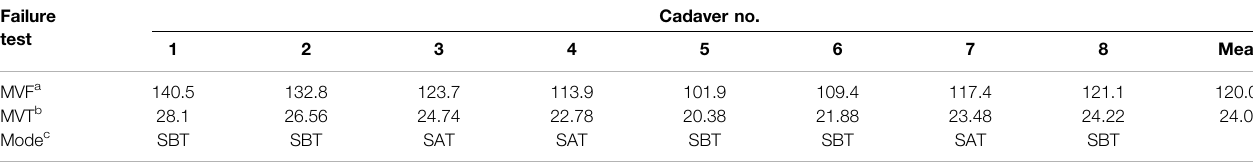
TABLE 3 | Maximum valgus failure test.